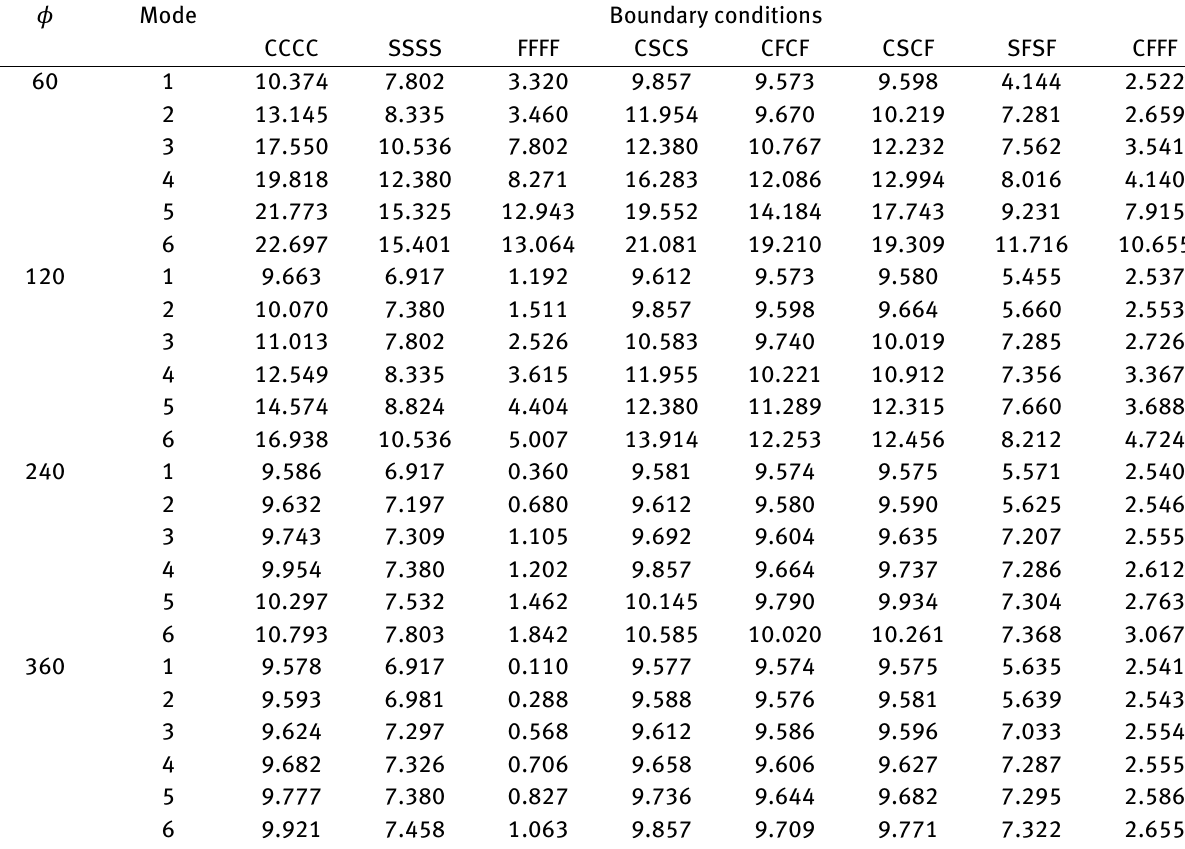
Table 5: Frequency parameters Ω for a [0 ∘ /90 ∘ /90 ∘ /0 ∘ ] laminated annular sector plate with different included angles and boundary